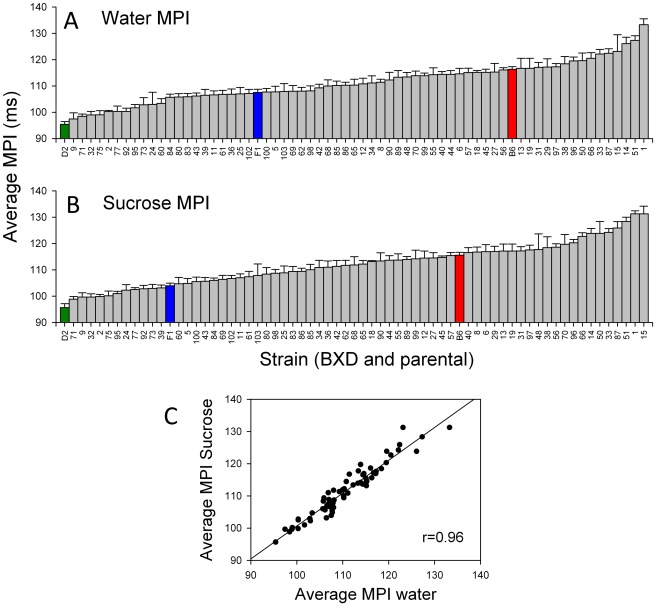
Histograms for average (± SE) mean primary inter-lick interval (MPI) across all BXD, parental, and F1 strains.A. Water MPI. B. Sucrose MPI. Green, blue and red bars denote values for D2, F1 and B6, respectively. C. Scatter plot of strain averages for water MPI and sucrose MPI.